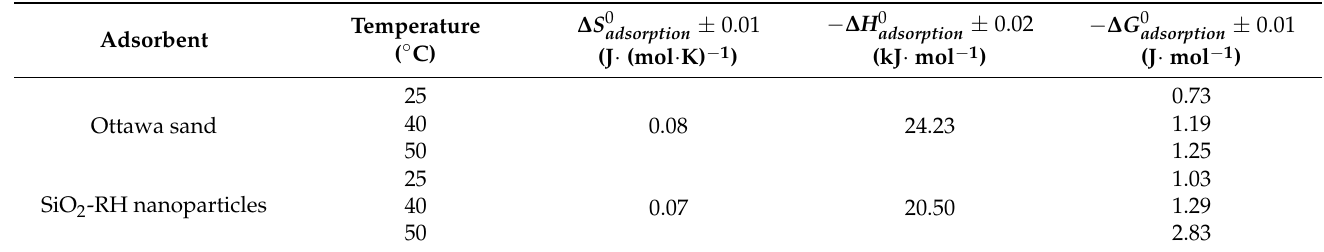
Table 5. Thermodynamics parameters for bio-fluid adsorption isotherms onto the sand rock and SiO 2 -RH nanoparticles.